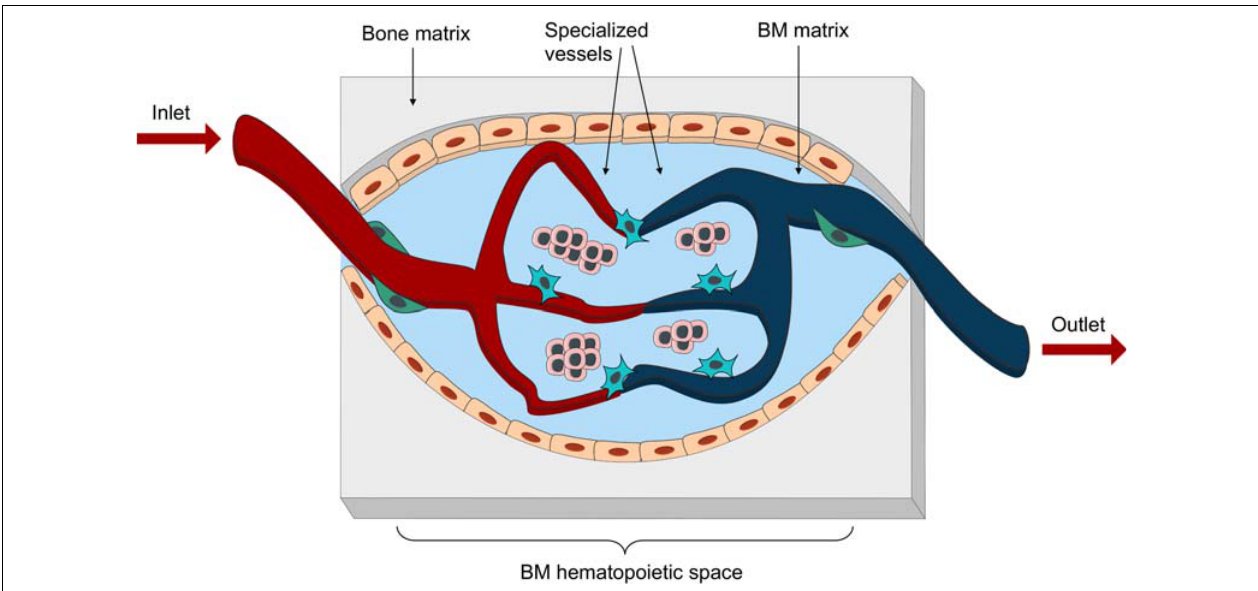
FIGURE 4 | Bioengineered vascularized BM niche unit. Schematic representation of the essential elements to be reproduced in an engineered vascularized BM niche-on-a-chip. These would include different matrix for bone and marrow space, as well as an intricate net of specialized vessels in close proximity with stromal and hematopoietic